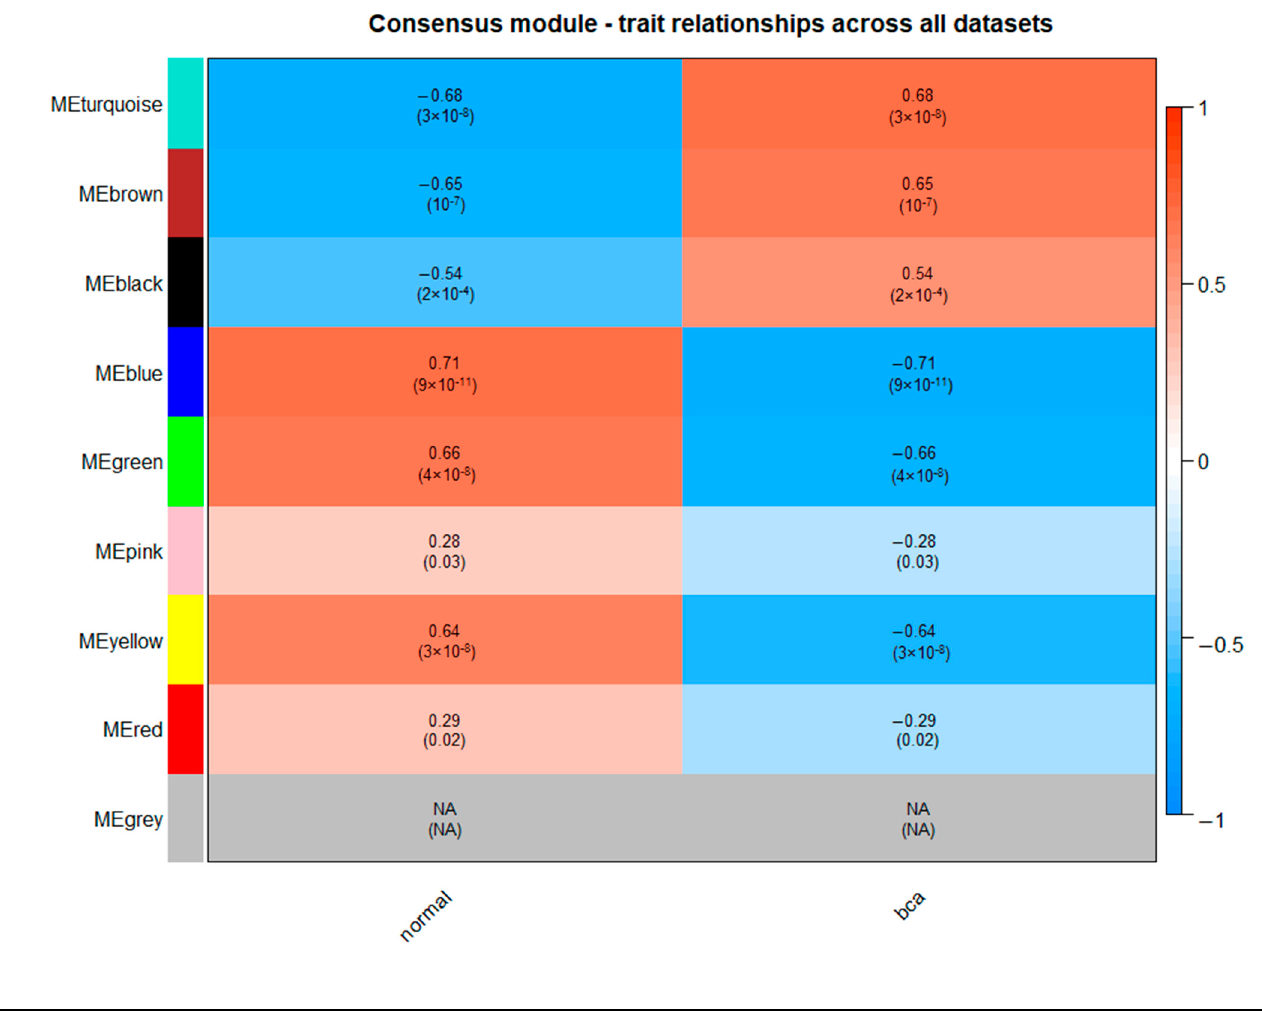
Figure 10. Heatmap of the consensus relationships of consensus module eigengenes and phenotypic traits. Each row corresponds to a consensus module eigengene and each column corresponds to the phenotypic characteristic. Each cell contains the corresponding correlation (ranging from blue to red) and p -value. Table 4. The key hub genes of our study are defined as the intersection of hub genes between PPI network analysis and WGCNA.